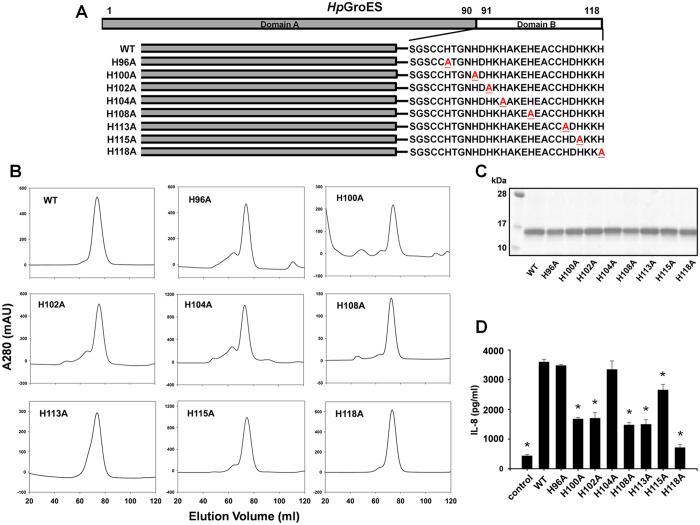
Purification and functional characterization of WT and histidine mutant proteins.(A) Schematic representation of the domain structures and domain B sequences (residues 91-118) of WT and histidine mutants. Mutation sites of histidine to alanine are underlined and marked in red. (B) FPLC profiles of WT and histidine mutant proteins on a size exclusion column, HiLoad 16/600 Superdex 200 pg. A280 was monitored to determine protein elution and purity. (C) Purified His-tagged fusion WT and histidine mutants were separated via 15% SDS-PAGE and stained with Coomassie Blue. A 1 μg protein sample was loaded from each elution fraction. (D) KATO-III cells were incubated for 16 h with 0.05 μM WT and histidine mutants, and IL-8 levels in the culture supernatant measured using the Quantikine ELISA assay kit. Data are presented as means ± SD of three experiments. *p < 0.05, compared to WT.